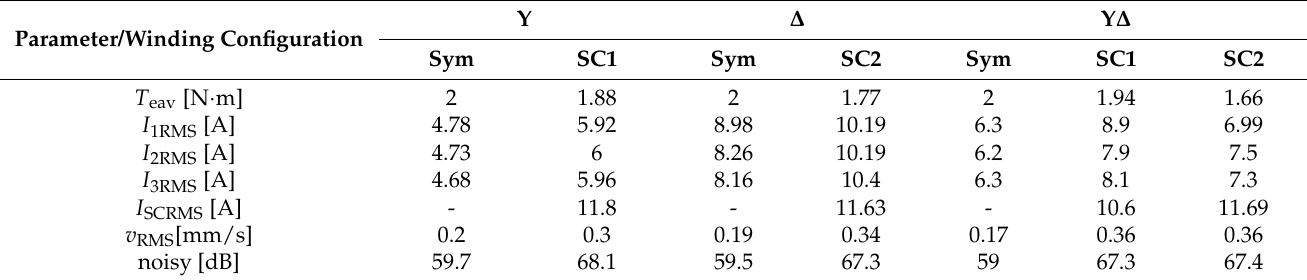
Table 5. Selected motor parameters—laboratory tests.